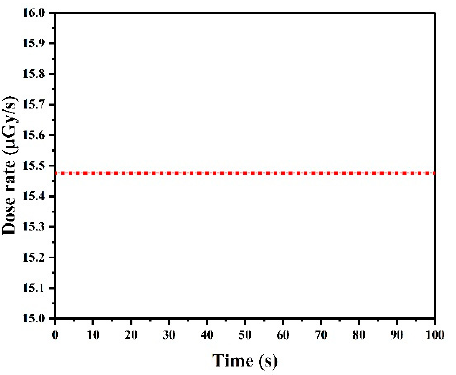
Figure 7. The X-ray dose rate of gated CNTs X-ray source at V a = 45 kV. The energy spectrum was recorded under 50 kV anode voltage by the Cd-Te X-ray energy spectrum detector, as shown in Figure 8. The two peaks at 17.48 and 19.58 keV in the X-ray spectrum correspond to characteristic emissions of the K-shell of the Mo target [48].